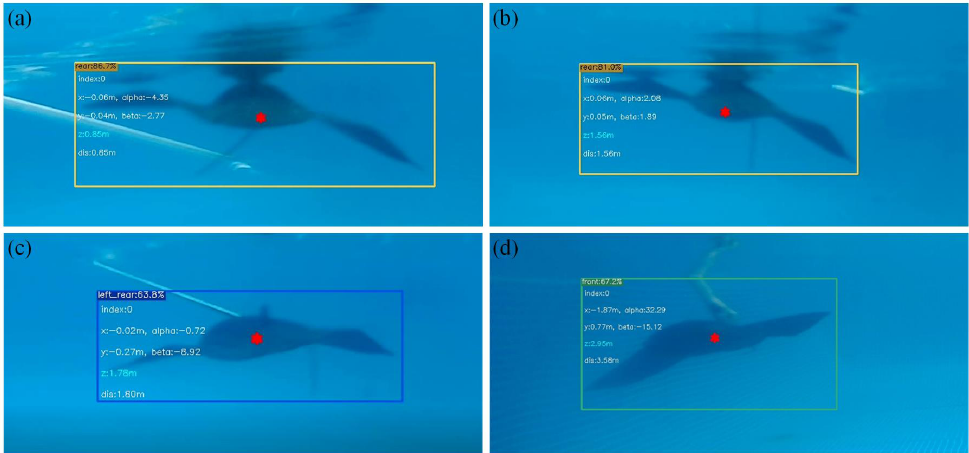
Figure 12. Results of relative distance and bearing estimation based on object detection: ( a ) 1 m; ( b ) 1.5 m; ( c ) 2 m; ( d ) 2.5 m, where the red dot denotes the center point of predicted bounding